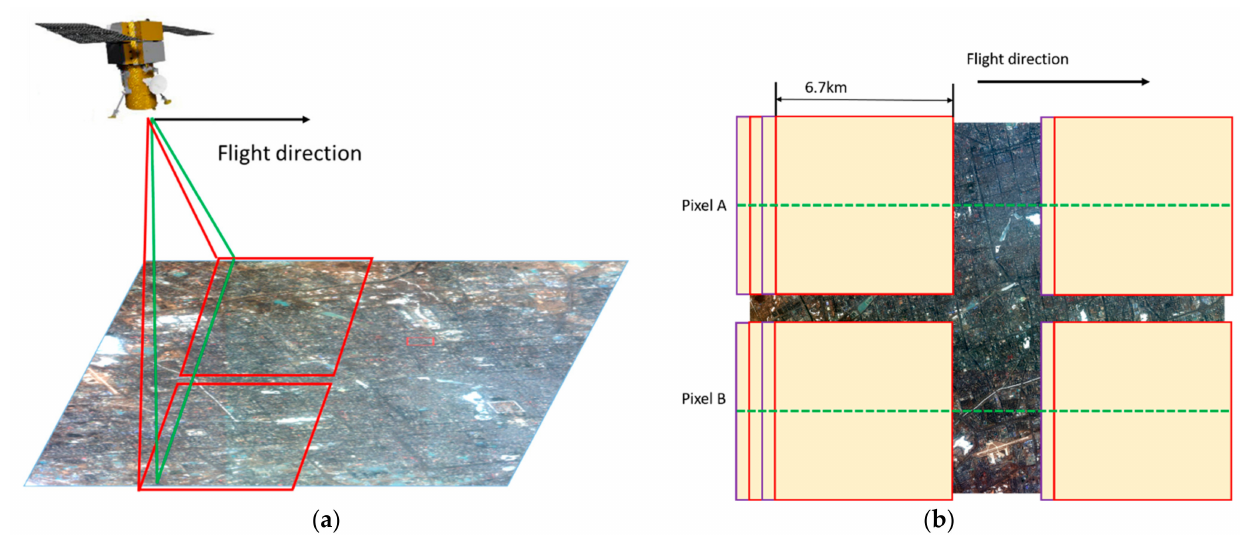
Figure 2. ( a ) Synchronous detection mode. ( b ) Shooting tracks of SMAC. The black arrow represents the flight direction of satellite, and the bottom image represents the multispectral images from main sensor. The base of the green triangle in ( a ) refers to the swath width of the remote sensing image. The red box pixels in ( a ) and the golden-filled box pixels in ( b ) mean the measurements of SMAC, and the spatial resolution of SMAC is 6.7